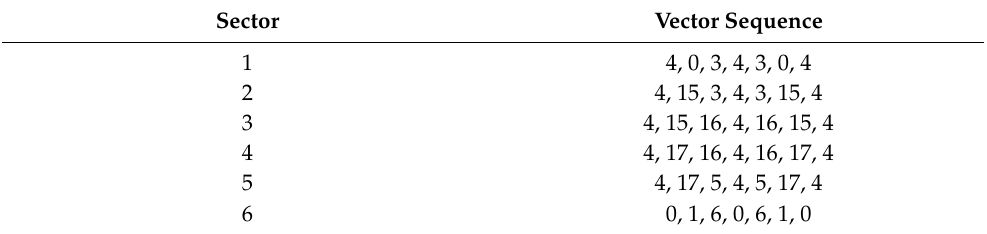
Table A5. Vector switching sequences of the fourth outer hexagon, by the ith designation (V i ).